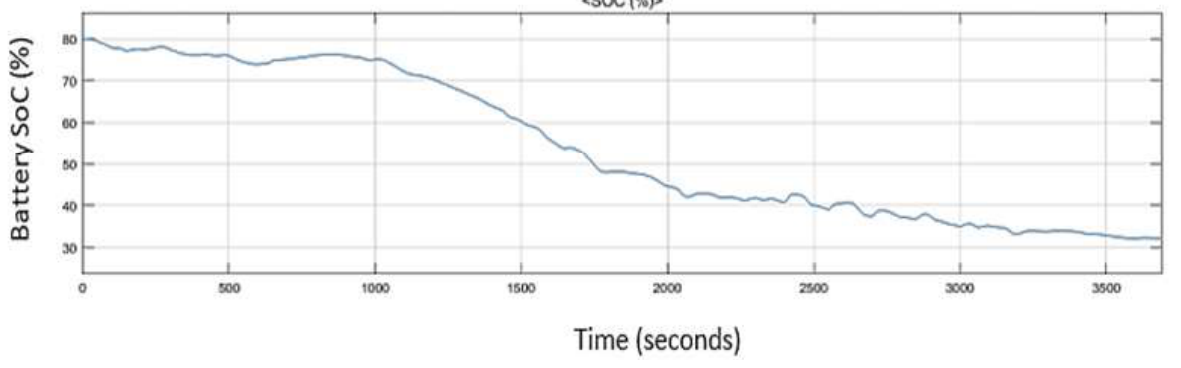
Figure 11. SoC discharge between 80% SoC to 30% SoC over drive cycle 3.